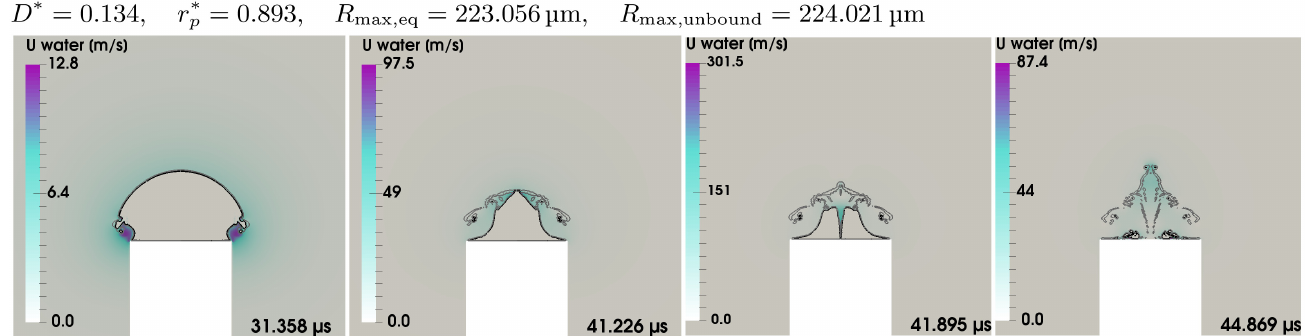
Figure 19. Mushroom bubble with the magnitude of the flow velocity of the liquid. Bubble at r ∗ p = 0.893 and D ∗ = 0.134. Very small overlap at maximum volume over the pillar rim. More examples with this r ∗ p in Figure A4 in Appendix E. Cylinder radius is